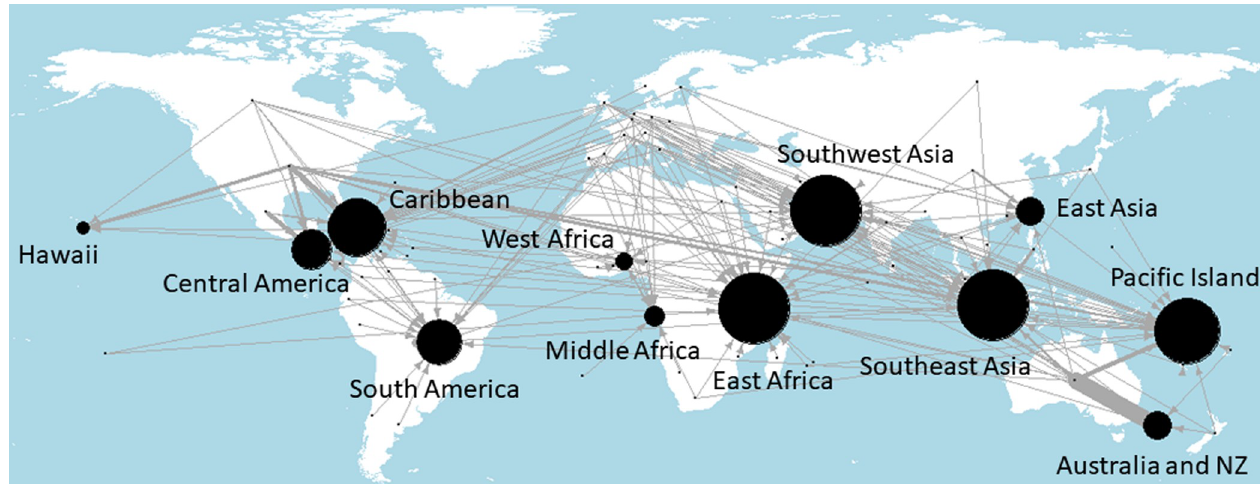
Fig 4. Directed network of the author country location with edge arrows going to the tropical region of research. Black circular nodes indicate research regions and the in-degree (i.e., the number of edges coming into the region).